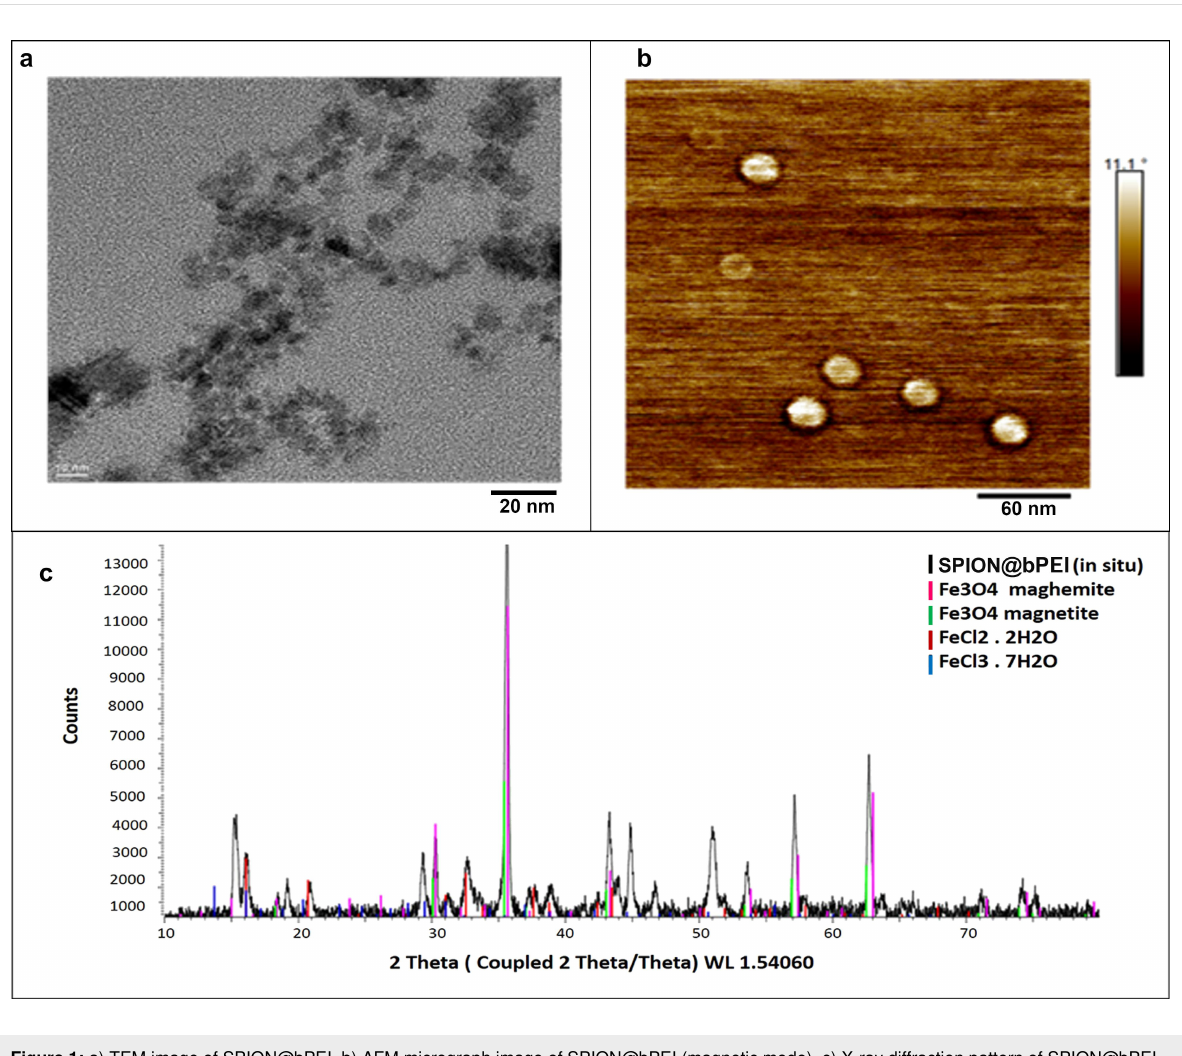
Figure 1: a) TEM image of SPION@bPEI. b) AFM micrograph image of SPION@bPEI (magnetic mode). c) X-ray diffraction pattern of SPION@bPEI prepared via the in situ coating method. Since the presence of the polymer prevented the observation of a diffraction pattern, it was burned under